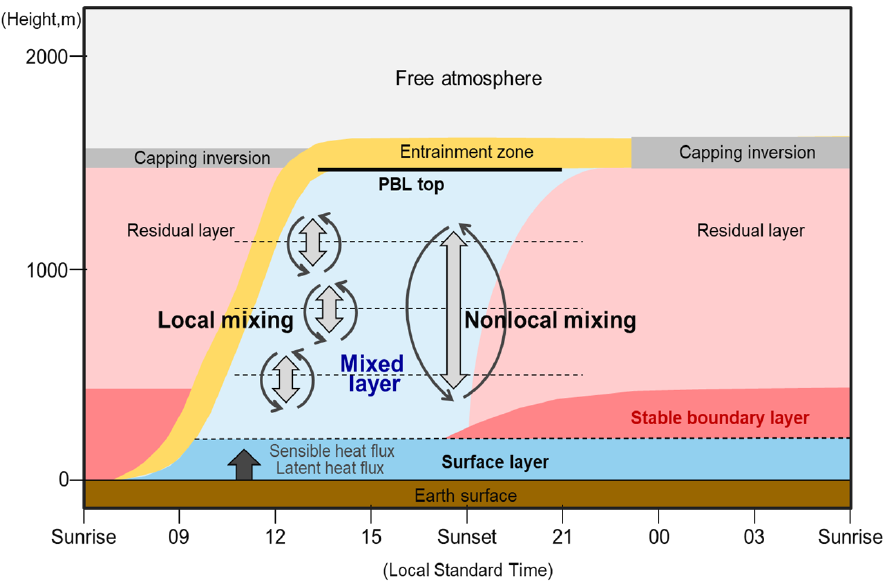
Figure 2. Schematic of local and non-local mixing processes in the PBL (modified from Ahasan et al., 2014 [45]).